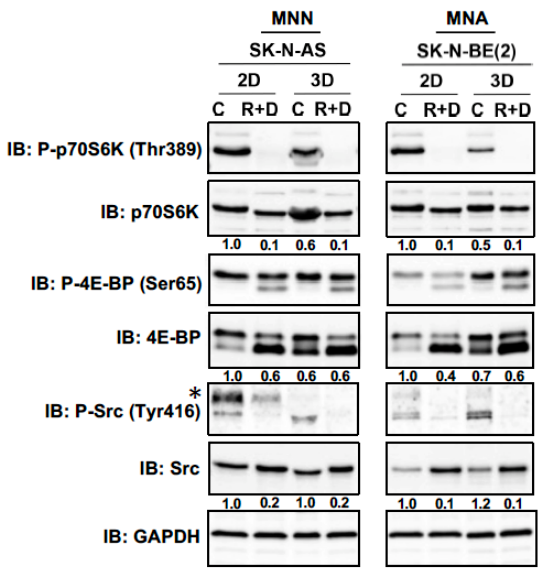
Figure 6. Neoplastic signaling pathway response to R+D ‘pre-treatment’ comparing 2D and 3D cul- tures. Immunoblot (IB) analysis showing the phosphorylation status of ribosomal protein S6 kinase (p70S6K), translation initiation factor 4E-BP and tyrosine kinase Src under control (C)- and Rapamy- cin plus Dasatinib (R+D)-treated conditions in two-dimensional (2D) monolayer and three-dimen- sional (3D) spheroid cultures of neuroblastoma cell line SK-N-AS and SK-N-BE(2). Numbers below bands state phosphoprotein (P) normalized to total protein expression. GAPDH was applied as loading control. C: Vehicle-treated control cells. R+D: Rapamycin plus Dasatinib treatment as de- picted in Table 2. Star (*): unknown band. MycN-non-ampli fi ed (MNN), MycN-ampli fi ed (MNA). IB: Immunoblot. Original immunoblot (IB) images (Figure S4).